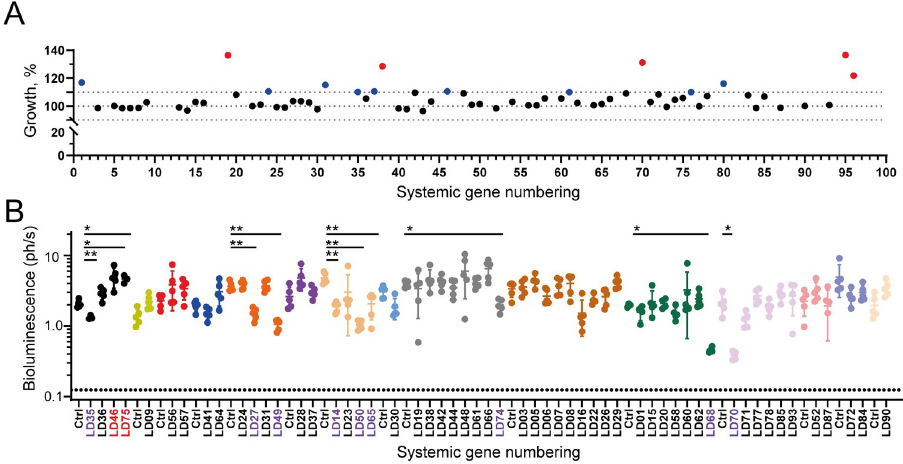
Fig 3. Most L . donovani mutants lacking cell surface or secreted proteins did not affect in vitro growth or the ability to infect mammalian hosts. ( A ) The growth rates of PCR-confirmed gene-targeted L . donovani mutants were calculated using promastigotes in logarithmic growth, and were normalised to that of an age-matched parental control from a single culture maintained in logarithmic growth. Black dots represent a < 10% difference in growth rate, blue dots between 10 and 20% difference and red greater than 20% difference compared to the parental line. ( B ) L . donovani parasites with targeted mutations in cell surface and secreted proteins were able to establish infections in a mammalian host. Each gene-targeted parasite line was used to infect groups of five female BALB/c mice and the infection monitored by bioluminescent imaging. Colours represent cohorts of animals that were infected with 1x10 8 stationary phase promastigotes and liver parasitemia quantified at two weeks post infection using bioluminescence; data points represent mean ± s.d.; n � 3. Significance was assessed using a Brown-Forsythe and Welch ANOVA test with significance p < .05 ( � ) or p < .005 ( �� ). Systematic numbers have been coloured red for mutants that displayed exacerbated infections and purple for mutants with attenuated infections. Dotted line represents the mean background bioluminescence in uninfected mice. The units of bioluminescence are reported as 1 x 10 6 photons per second.